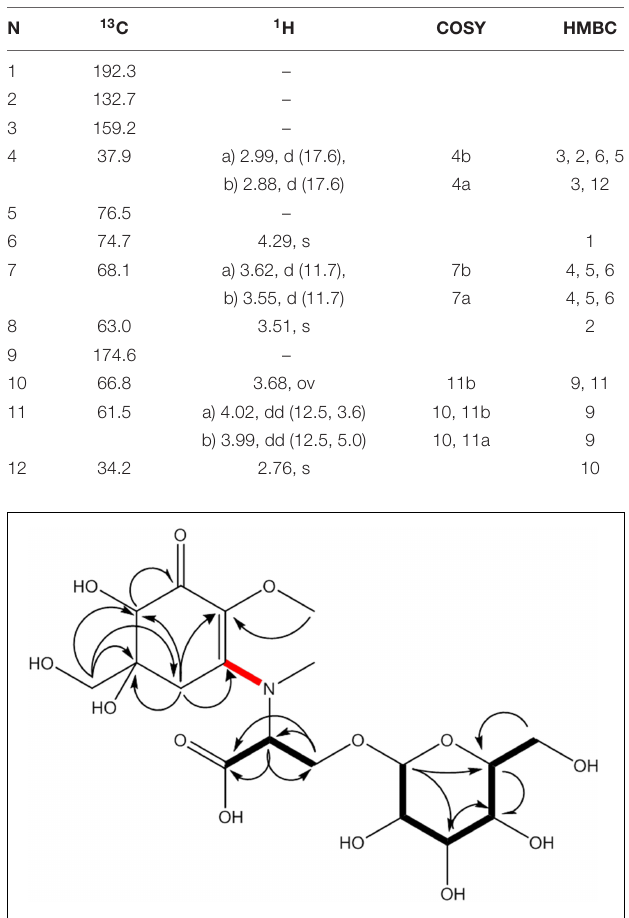
TABLE 4 | 1 H and 13 C NMR chemical shifts (in ppm) and proton coupling constants (Hz, in parentheses) of the novel MAA N-(4,5-dihydroxy-5- (hydroxymethyl)-2-methoxy-3-oxocyclohex-1-en1-yl)-N-methylserine (klebsormidinB) isolated from the terrestrial green alga Klebsormidiumcrenulatum .